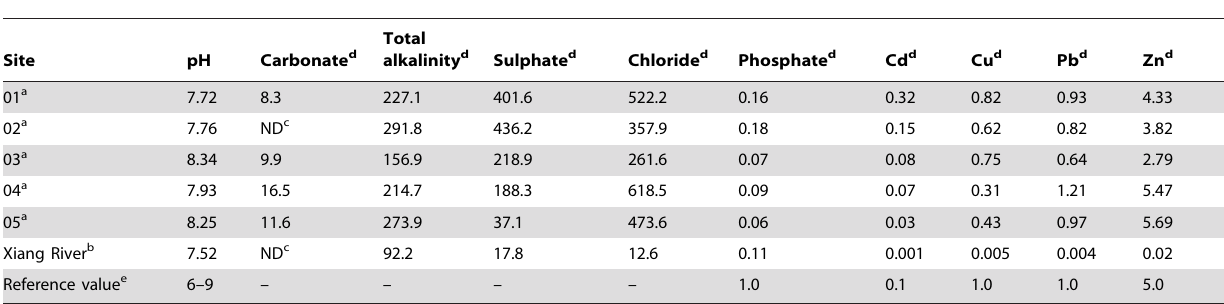
Table 2. The main characteristics and heavy metal concentrations in Xiawangang